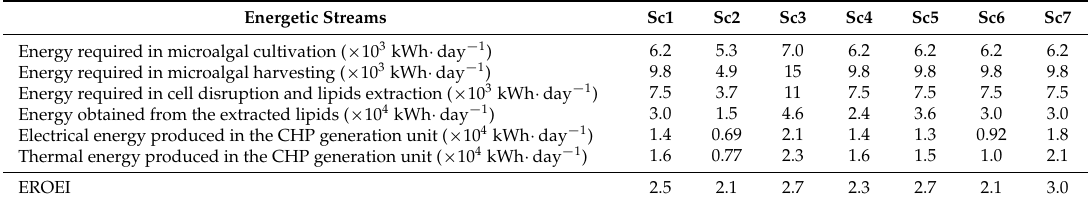
Table 5. Net energy balance in each of the studied scenarios (Sc). Energetic Streams Sc1